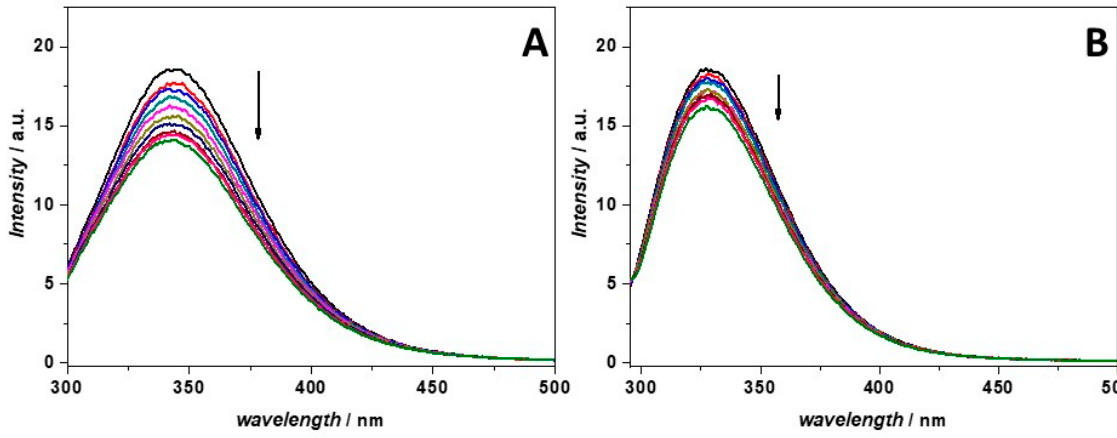
Figure 3. Fluorescence emission spectra of ( A ) HSA and ( B ) hTf in the absence (black spectra) and in the presence of increasing DoHuRu/DOTAP vesicles concentrations (colored spectra). The arrows indicate the direction of the effects due to increasing concentrations of DoHuRu/DOTAP. The excitation wavelength was set at 280 nm. All the experiments were performed in a 1-cm path length quartz cuvette at the temperature of 20 °C.